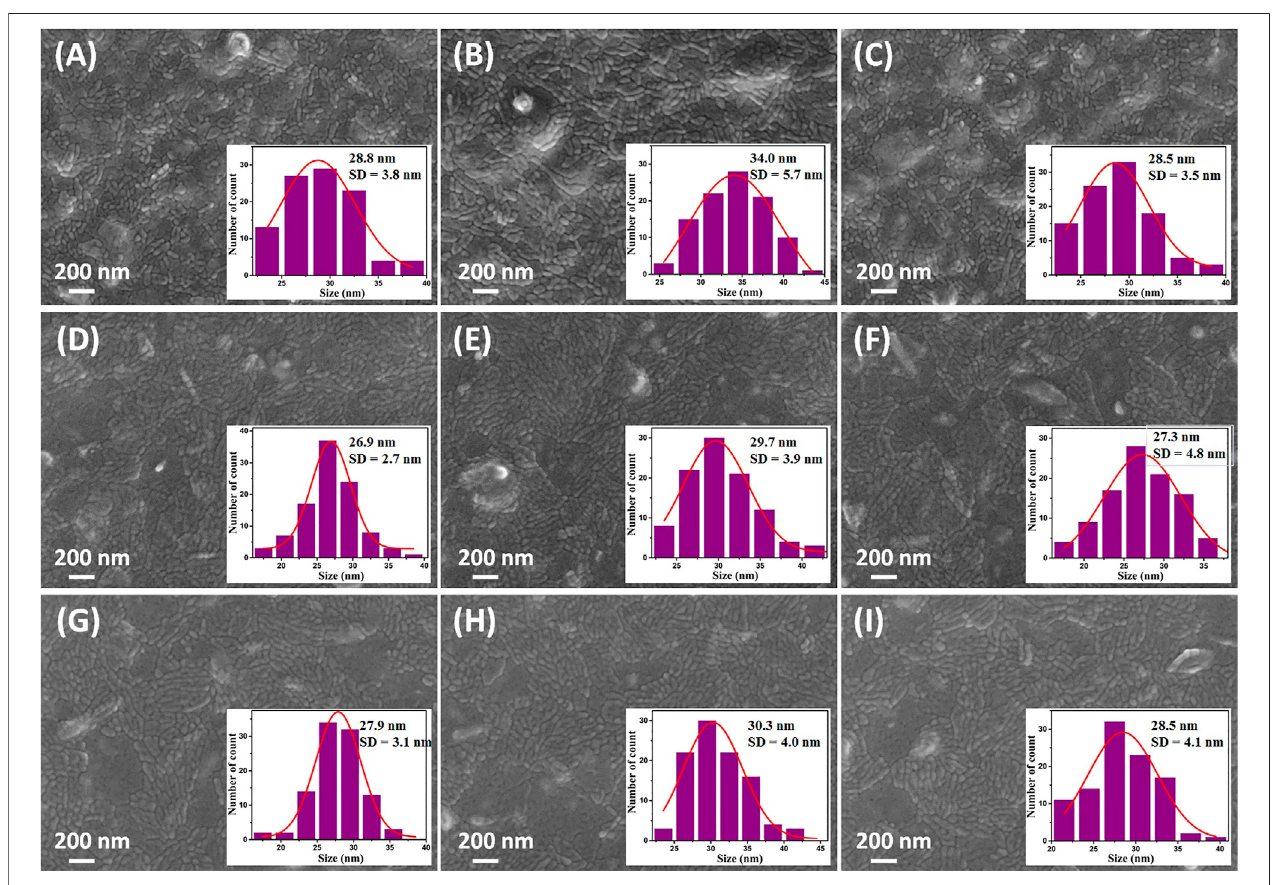
FIGURE 2 | FE-SEM surface morphology of samples (A) D30 (B) D60 and (C) D110 prepared using dip coating and (D) S4000 (E) S900 and (F) S600 for spin coated fi lms and (G) C30 (H) C60 and (I) C110 fabricated via the combined dip/spin coating techniques respectively.